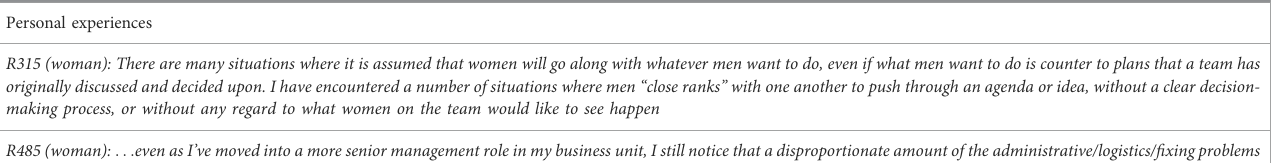
TABLE 2 Representative quotes associated with the four themes that emerged from our analysis. Quotes were drawn from two open-ended survey questions: Q40Pleaseshare anypersonalre fl ectionsabouthowyouhavebeentreatedinrelationtoyourgender[N=402:225(54%)womenand233(36%)men]andQ37Please list the top three issues/ideas your organization could address to ensure women are included in science and conservation strategy and practice at TNC [N = 485: 252 (61%) women and 233 (48%) men]. Respondents ’ experiences and recommendations to address gender inequity in conservation (representative